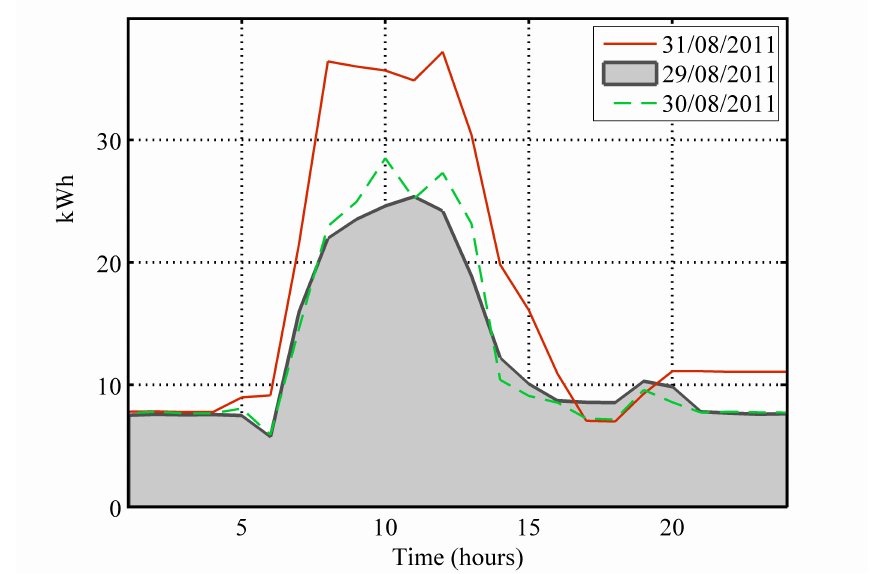
Figure 2. Example of three consecutive consumption days (“Rectorat”).